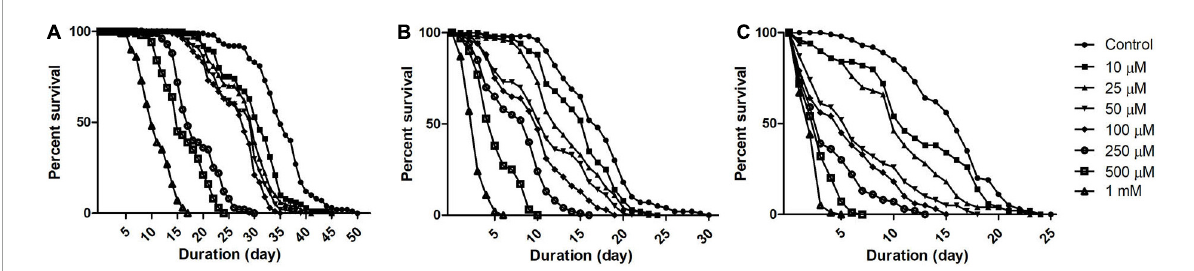
FIGURE1 Dose and time-dependent mortality of Drosophila (OK) exposed to rotenone during different phases of adult life. Mortality pattern among adult male flies of early health span (A) , late health span (B) , and transition phase (C) , exposed to seven different concentrations of rotenone (10, 25, 50, 100, 250, 500, and 1,000 µ M) showed concentration-dependent lethality. Mortality data were collected every 24 h for each group till all the flies were dead. There was no mortality up to the 6th day for health span flies and the 3rd day for late health and transition phase flies. Comparison of survival curves reveals that the response difference among different tested concentrations was significant (log-rank [Mantel–Cox] test. p <